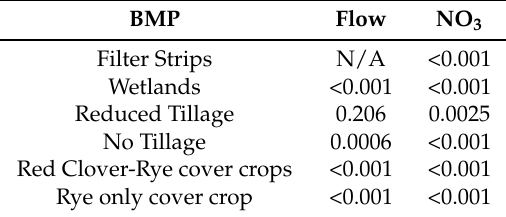
Table 2. Yearly Wilcoxon p-values.